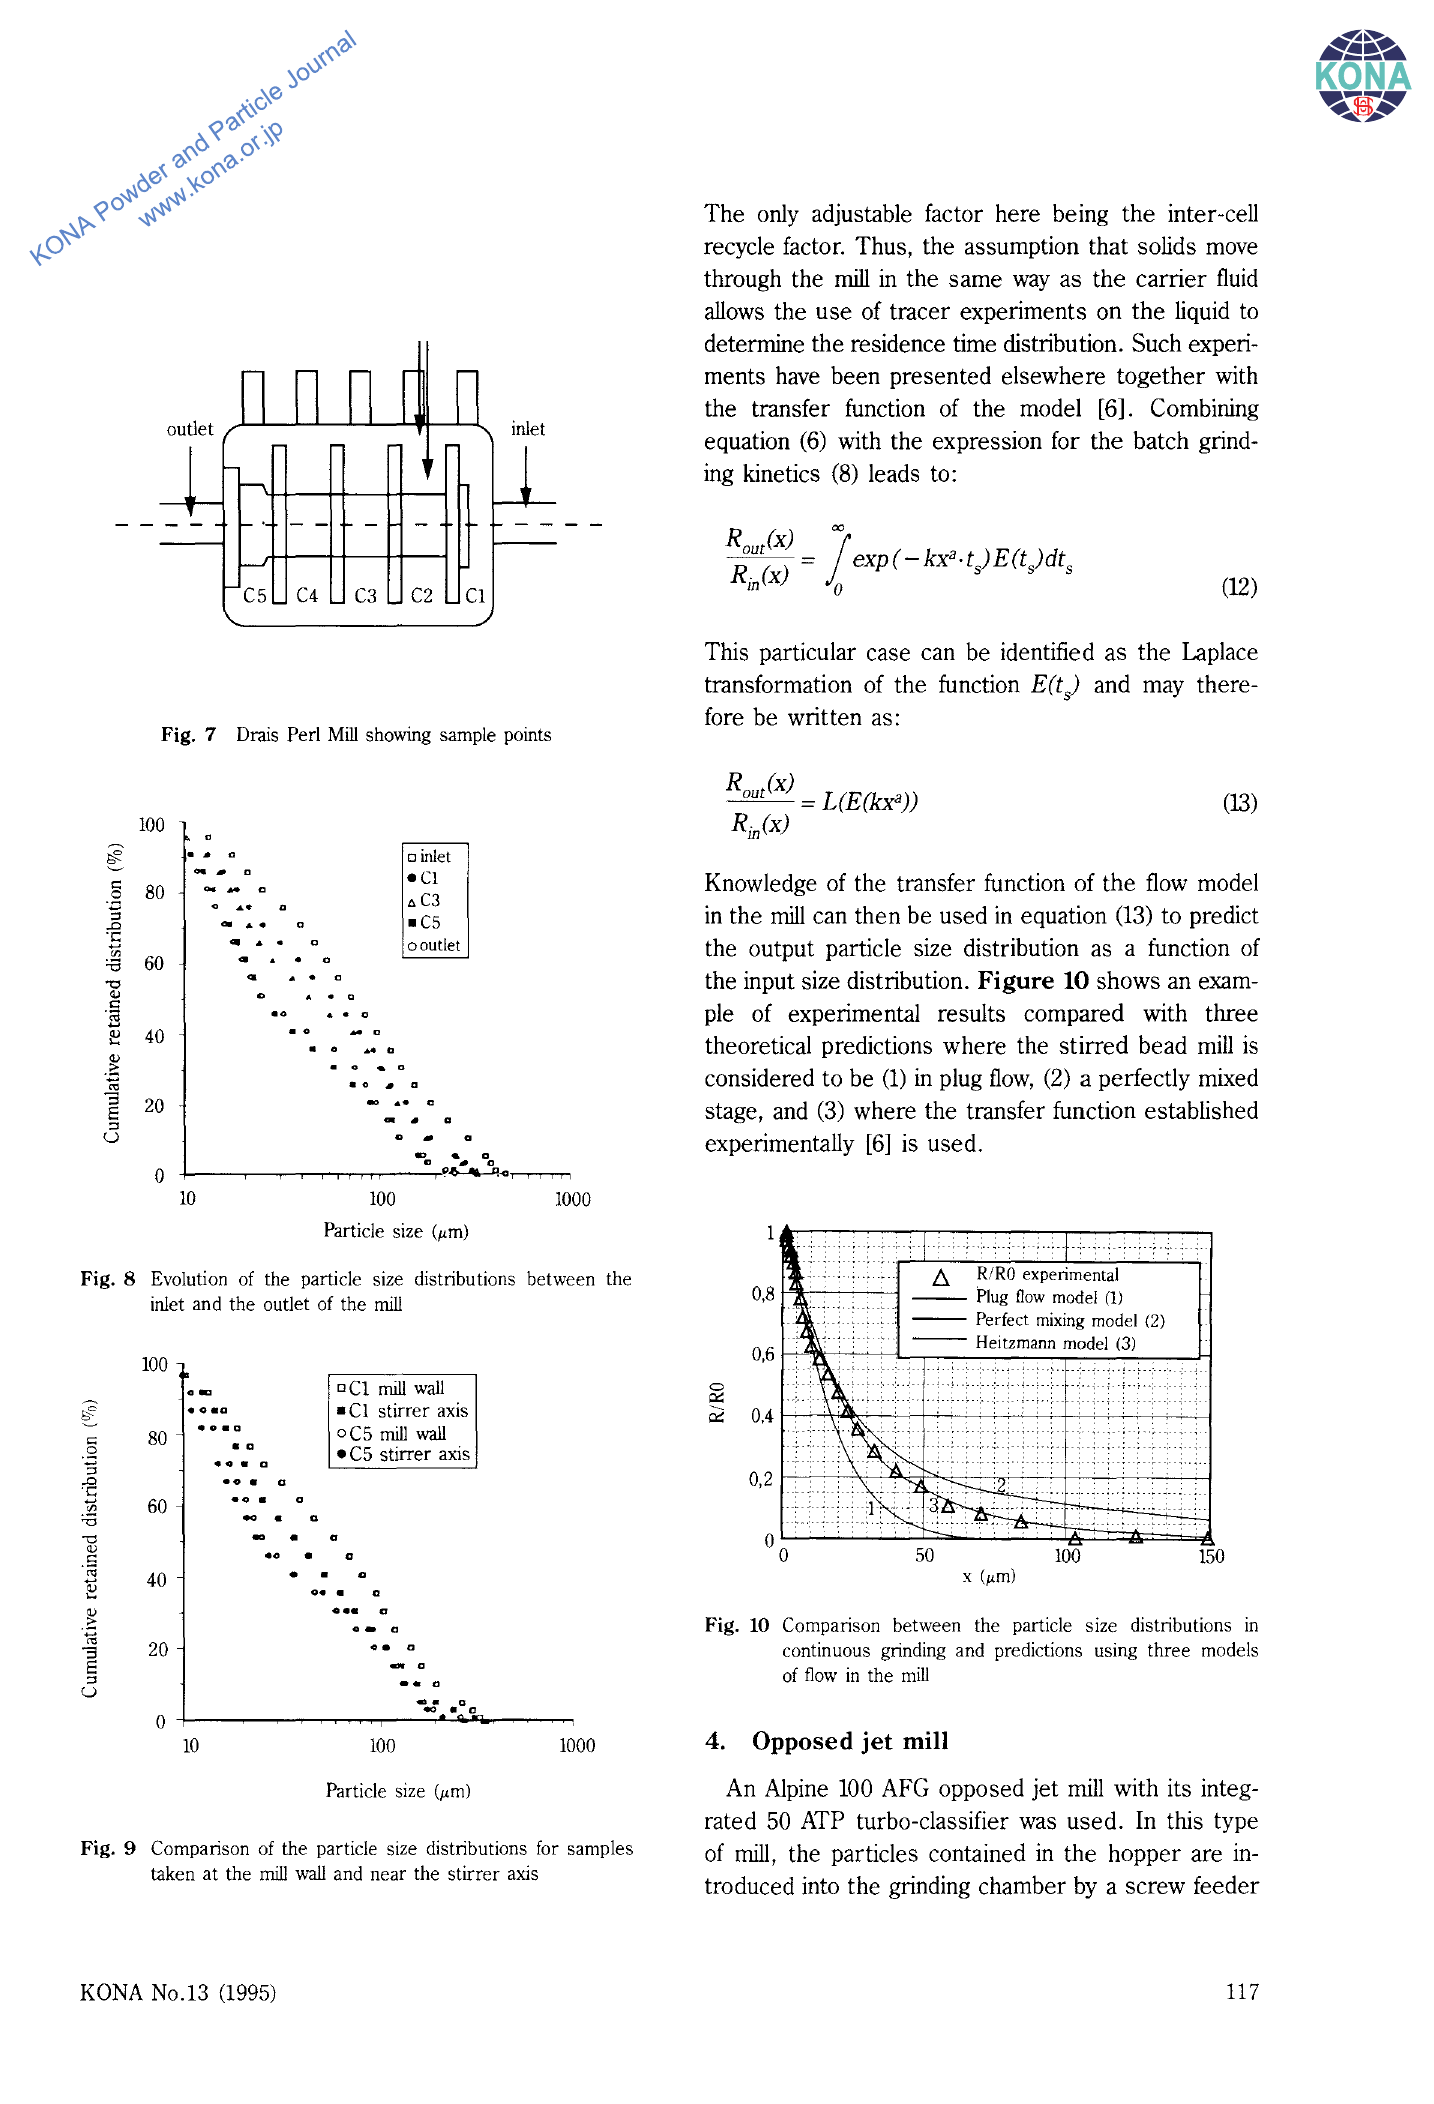
Fig. 10 Comparison between the particle size distributions in continuous grinding and predictions using three models of flow in the